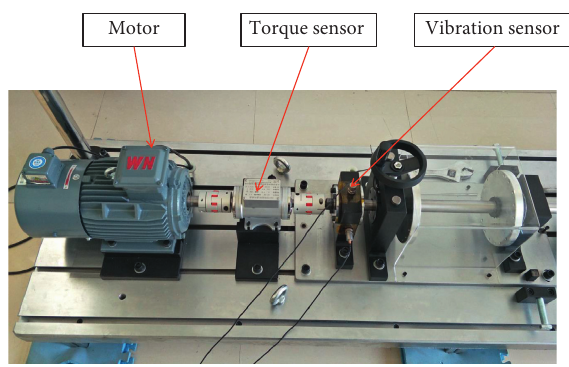
Figure 4: Rolling bearing fault diagnosis